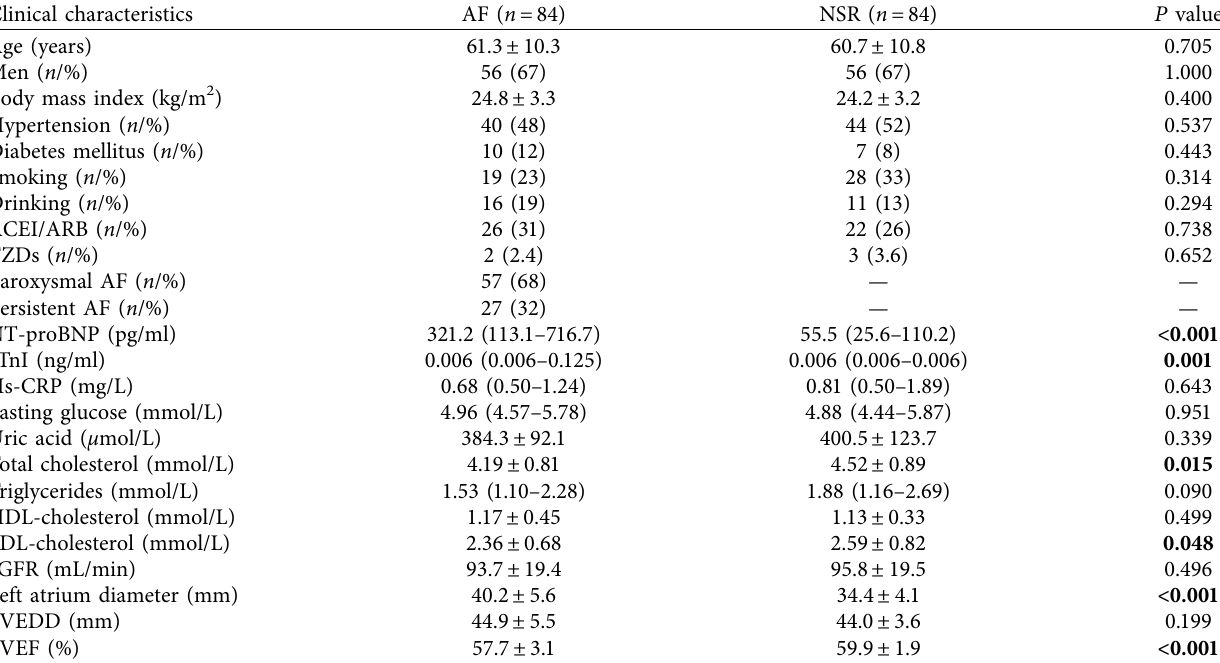
Table 1: Clinical characteristics of patients with AF and controls with